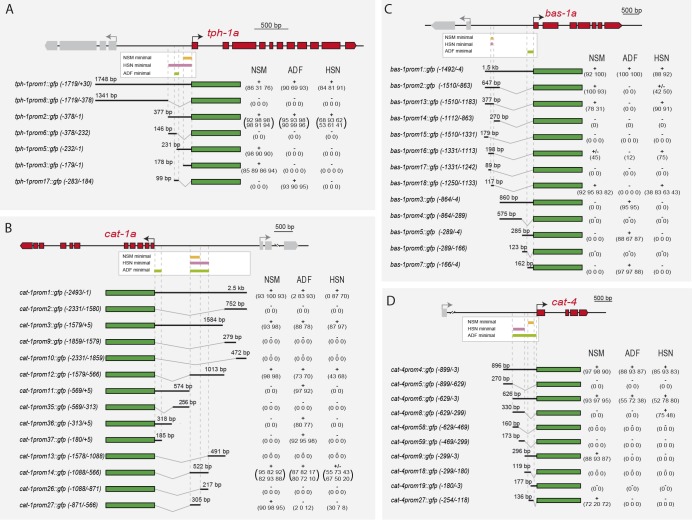
5HT pathway gene CRM analysis.Thick black lines symbolize the genomic region placed in front of GFP (green box) and dashed lines are used to place each construct in the context of the locus. White boxes underneath each gene summarize the smallest CRM that drives expression in each serotonergic neuron subclass. Numbers in brackets represent the coordinates of each construct referred to the ATG. Each number represents the % of GFP cells in a particular transgenic line. +: >60% GFP-positive cells; +/−: 20–60% GFP cells; - < 20% GFP cells. n > 60 cells per line.